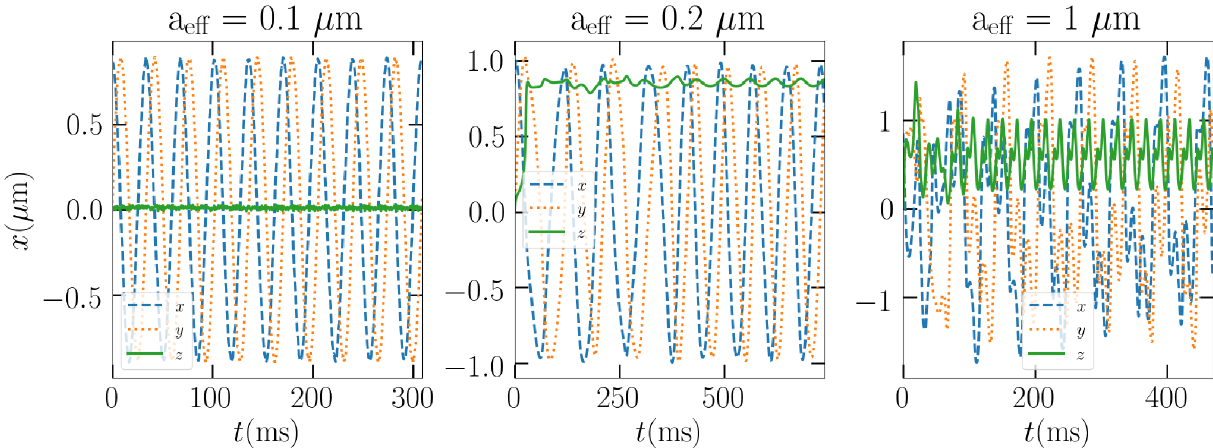
Fig 16. The paths of the 0.1, 0.2, and 1 μ m Gaussian ellipsoid particles in Laguerre-Gaussian (LG 03 mode) beam, respectively.